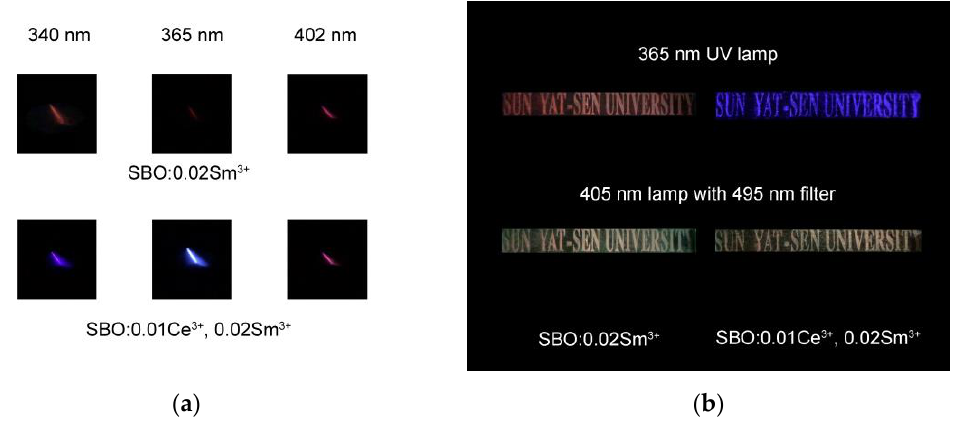
Figure 6. ( a ) Luminescent images of SBO:0.02Sm 3+ and SBO:0.01Ce 3+ , 0.02Sm 3+ upon 340, 365 and 402 nm excitation of xenon lamp at RT; ( b ) Luminescent patterns of “SUN YAT-SEN UNIVERSITY” under 365 nm and 405 nm commercial lamp excitations based on SBO:0.02Sm 3+ and SBO:0.01Ce 3+ , 0.02Sm 3+ samples.